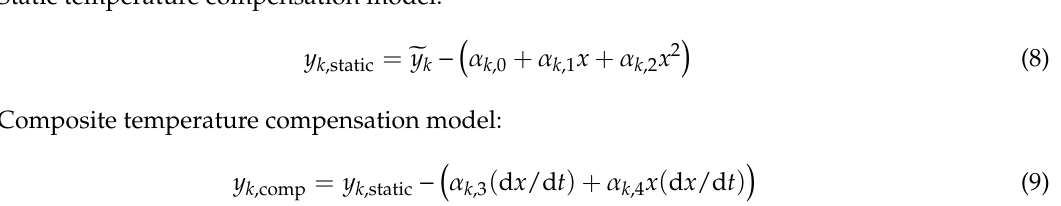
Table 3. The RLG’s bias before and after temperature compensation (pulses).